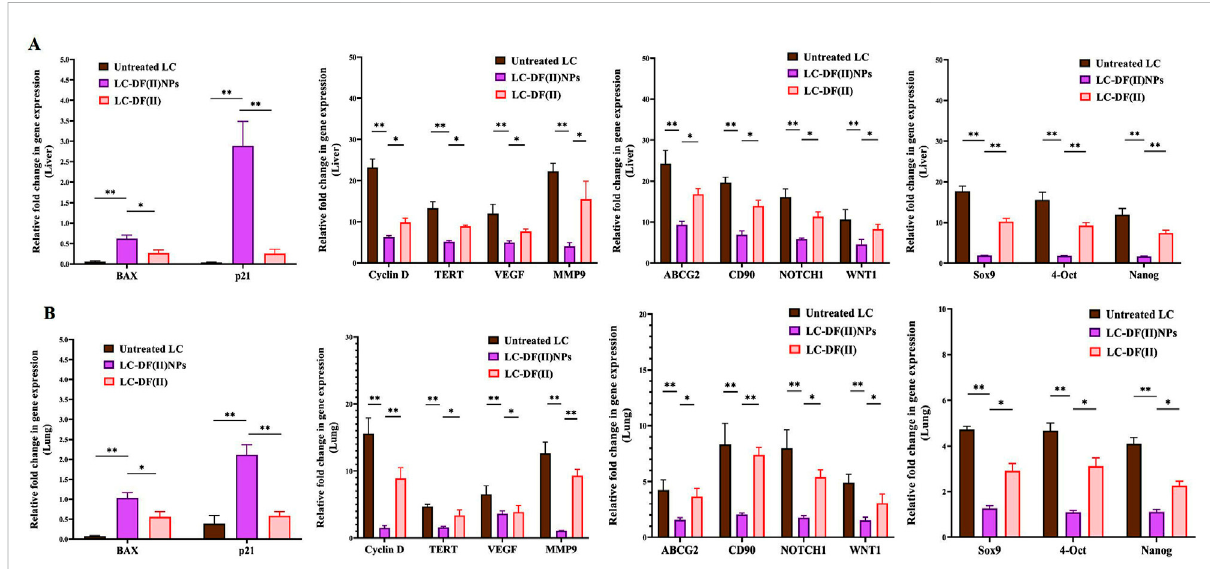
FIGURE 5 Impact of DF(II) complexes on the gene expression of apoptotic, oncogenes, and stemness genes. Relative fold change in the gene expression of apoptotic genes (BAX and p21), key oncogenes (cyclin D, telomerase reverse transcriptase (TERT), vascular endothelial growth factor (VEGF), matrix metalloprotease (MMP) 9-mediated metastasis), and stemness (ATP Binding Cassette Subfamily G Member 2 (ABCG2), CD90, NOTCH1, WNT1, Sox9, 4-OCT, and Nanog) in tumor tissues, including (A) liver and (B) lung. Data are shown as mean ± SEM. LC-DF(II) NPs group was compared to the untreated LC and LC-DF(II) groups, considering statistically signi fi cant at p ≤ 0.05*, ≤ 0.005**, and ≤ 0.001***.